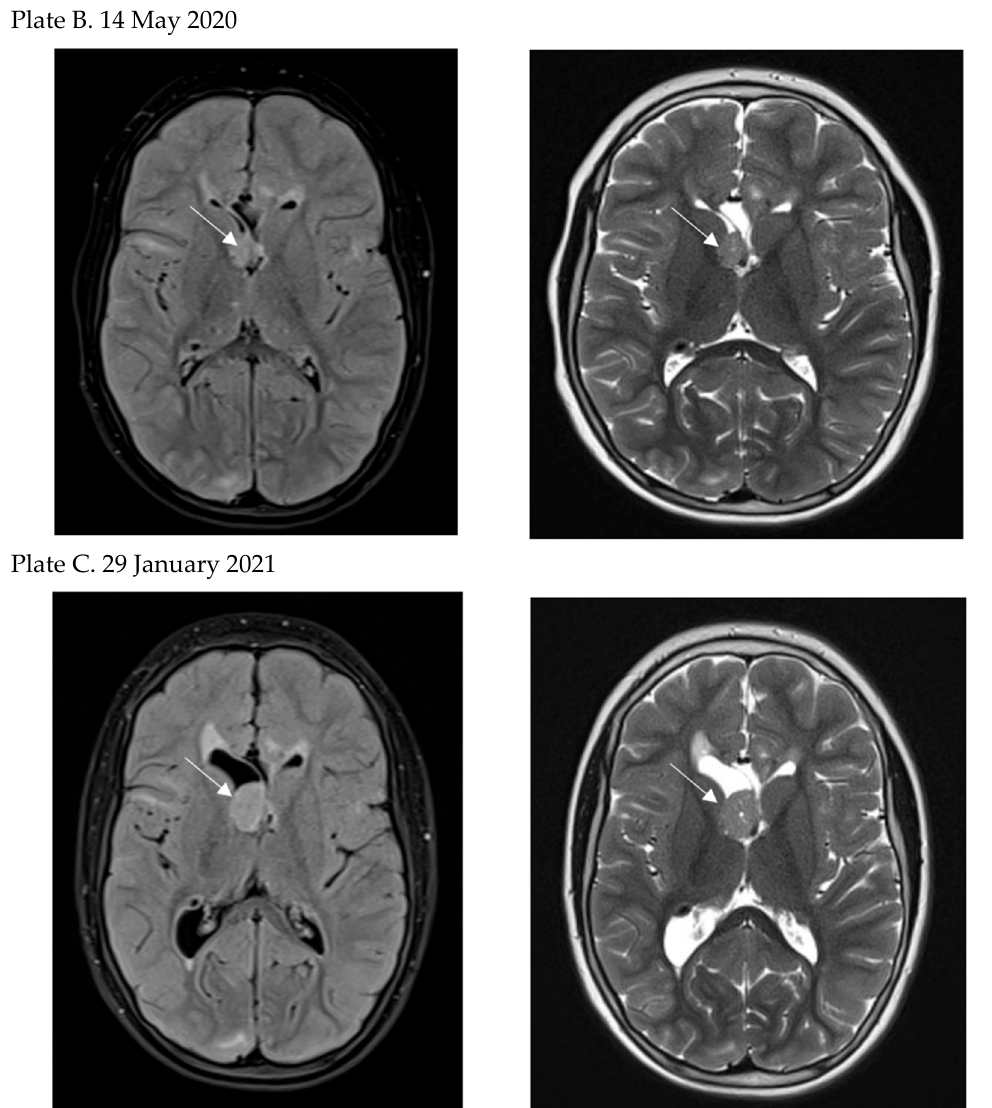
Figure 4. Growth of the SEGA in the proximity of foramen Monro during one year of follow-up ( plates A , B , C ). Pronounced hydrocephalus caused by growing SEGA is seen on plate C. This MRI image shows also a subcortical nodule in the right occipital lobe. (Courtesy of prof. Elzbieta Jurkiewicz, The Children’s Memorial Health Institute, Warsaw).